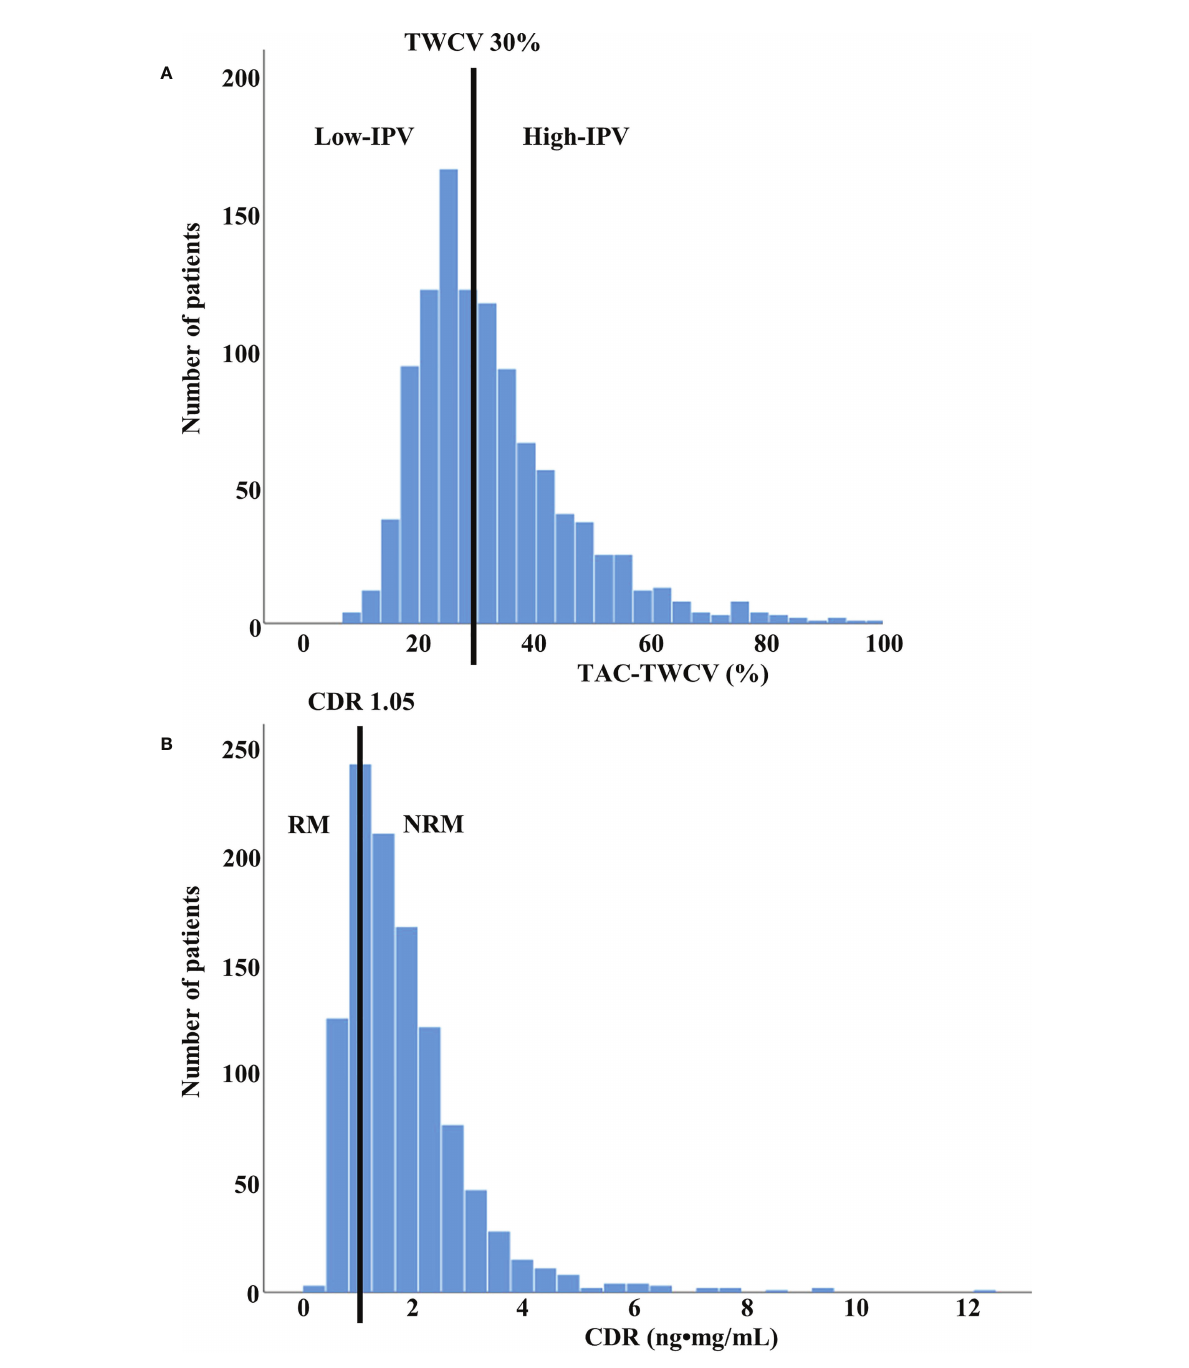
FIGURE 2 Distribution of TWCV and CDR values in study population (A) The distribution of TWCV in the study population for the fi rst year after transplant using TAC-C0. The patients were classi fi ed into low- and high-IPV groups based on TWCV values of ≥ 30% or <30%, respectively. The low-IPV and high-IPV groups included 558 and 522 patients, respectively. (B) The distribution of CDR in the study population for the fi rst 3 months after transplant using TAC-C0. Patients with CDR > 1.05 ng (cid:129) mg/mL and CDR < 1.05 ng (cid:129) mg/mL were classi fi ed as NRM and RM, respectively. NRM and RM groups included 827 and 253 patients, respectively. CDR, concentration-to-dose ratio; IPV, intra-patient variability; NRM, non-rapid metabolizer; RM, rapid metabolizer; TAC-C0, tacrolimus trough level; TWCV, time-weighted coef fi cient